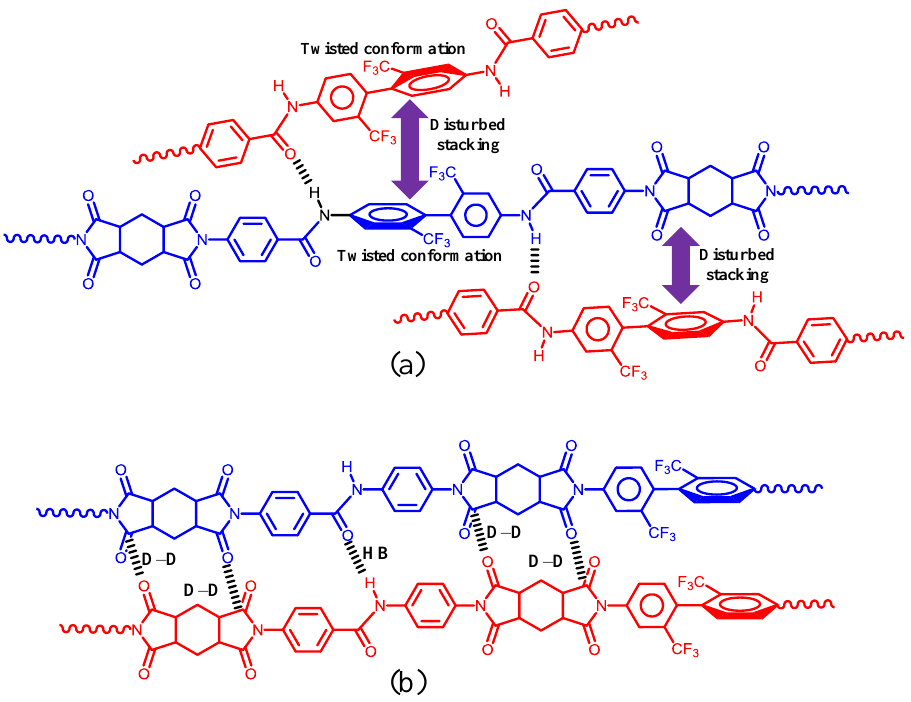
Figure 17. A schematic sketch expressing the difference of interchain interactions [hydrogen bonding (HB) and dipole–dipole (D–D) interaction between the imide C=O groups]: ( a ) H′-PMDA/AB-TFMB and ( b ) H′-PMDA/TFMB;DABA copolymers. Reproduced with permission from John Wiley & Sons [51].